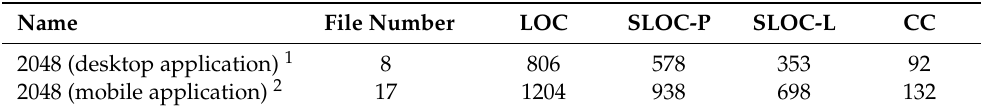
Table 3. Summary of experimental applications.